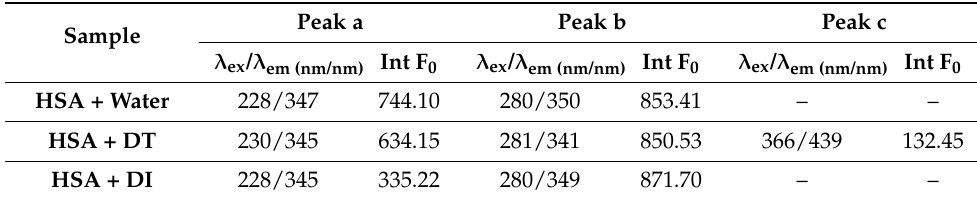
Table 4. Fluorescence results of 3D-measurements of water dragon extracts (DT and DI) in interaction with human serum albumin (HSA).